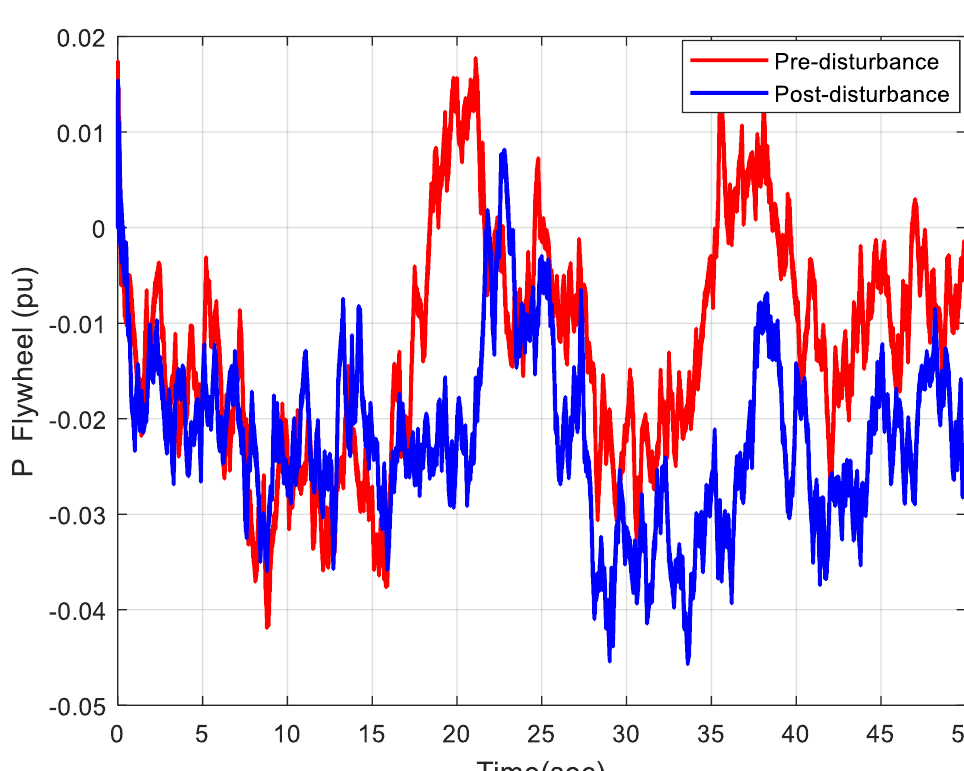
Figure 12. Battery power (pre- and post-disturbance).